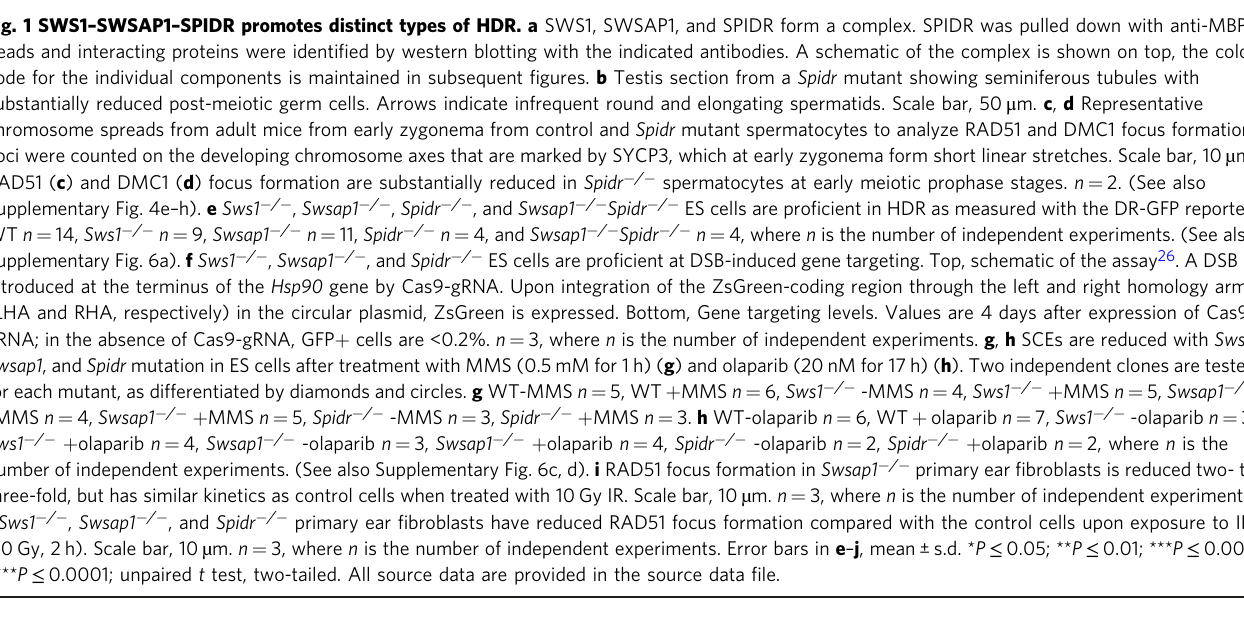
Fig. 1 SWS1 – SWSAP1 – SPIDR promotes distinct types of HDR. a SWS1, SWSAP1, and SPIDR form a complex. SPIDR was pulled down with anti-MBP beads and interacting proteins were identi fi ed by western blotting with the indicated antibodies. A schematic of the complex is shown on top, the color code for the individual components is maintained in subsequent fi gures. b Testis section from a Spidr mutant showing seminiferous tubules with substantially reduced post-meiotic germ cells. Arrows indicate infrequent round and elongating spermatids. Scale bar, 50 μ m. c , d Representative chromosome spreads from adult mice from early zygonema from control and Spidr mutant spermatocytes to analyze RAD51 and DMC1 focus formation. Foci were counted on the developing chromosome axes that are marked by SYCP3, which at early zygonema form short linear stretches. Scale bar, 10 µ m. RAD51 ( c ) and DMC1 ( d ) focus formation are substantially reduced in Spidr − / − spermatocytes at early meiotic prophase stages. n = 2. (See also Supplementary Fig. 4e – h). e Sws1 − / − , Swsap1 − / − , Spidr − / − , and Swsap1 − / − Spidr − / − ES cells are pro fi cient in HDR as measured with the DR-GFP reporter. Supplementary Fig. 6a). f Sws1 − / − , Swsap1 − / − , and Spidr − / − ES cells are pro fi cient at DSB-induced gene targeting. Top, schematic of the assay 26 . A DSB